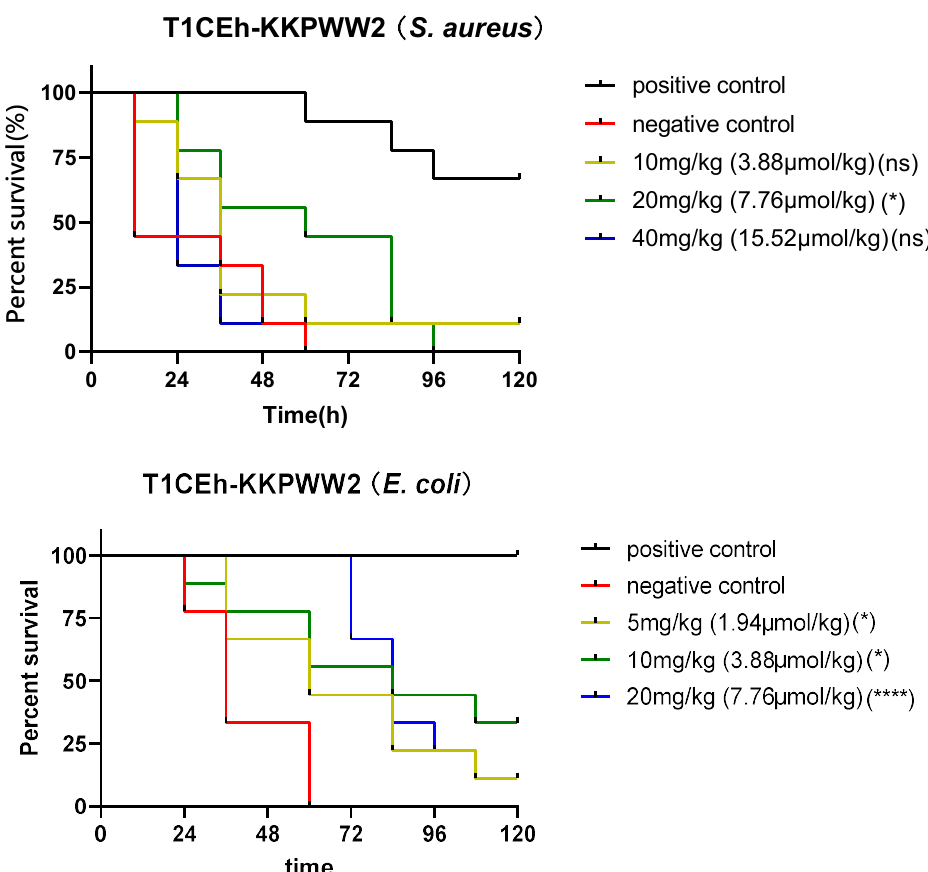
Figure 9. The survival curves of wax moth larvae infected by S. aureus and treated by peptide Temporin-1CEh, T1CEh-KKPW, T1CEh-KKPWW and T1CEh-KKPWW2, as well as infected by E. coli and treated by peptide T1CEh-KKPWW2. For the treatment of S. aureus infection, the positive and negative controls were 50 mg/kg of vancomycin and 0.9% NaCl solution, respectively. For the treatment of E. coli infection, the positive and negative controls were 25 mg/kg of ampicillin and 0.9% NaCl solution, respectively. The statistical analyses were performed by using the Mantel–Cox test between the negative group and dose groups, as well as the significant difference was indicated as * ( p < 0.05), *** ( p < 0.001) and **** ( p < 0.0001). The significant levels were indicated in parentheses behind the legend keys of each dose group.